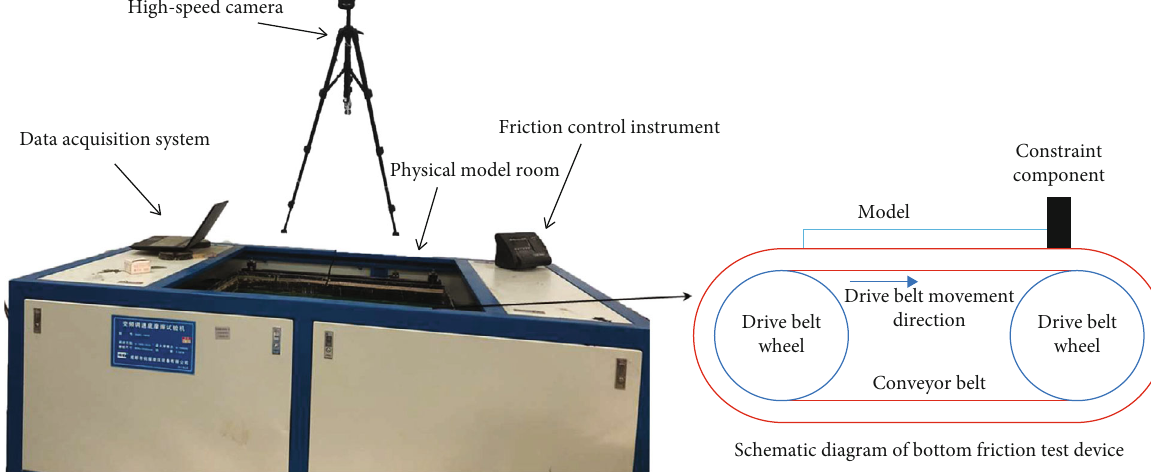
Figure 7: Bottom friction-based physical model test setup.